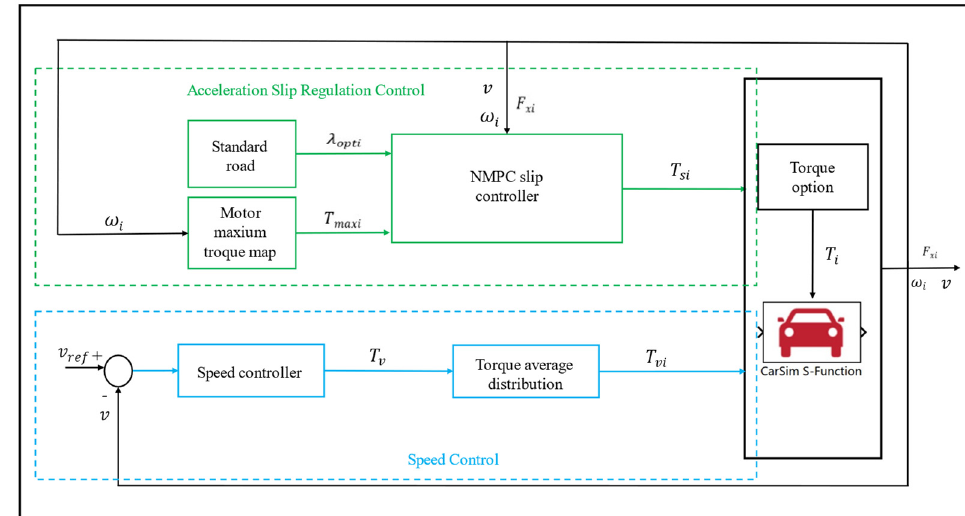
Figure 1. ASR control block diagram.